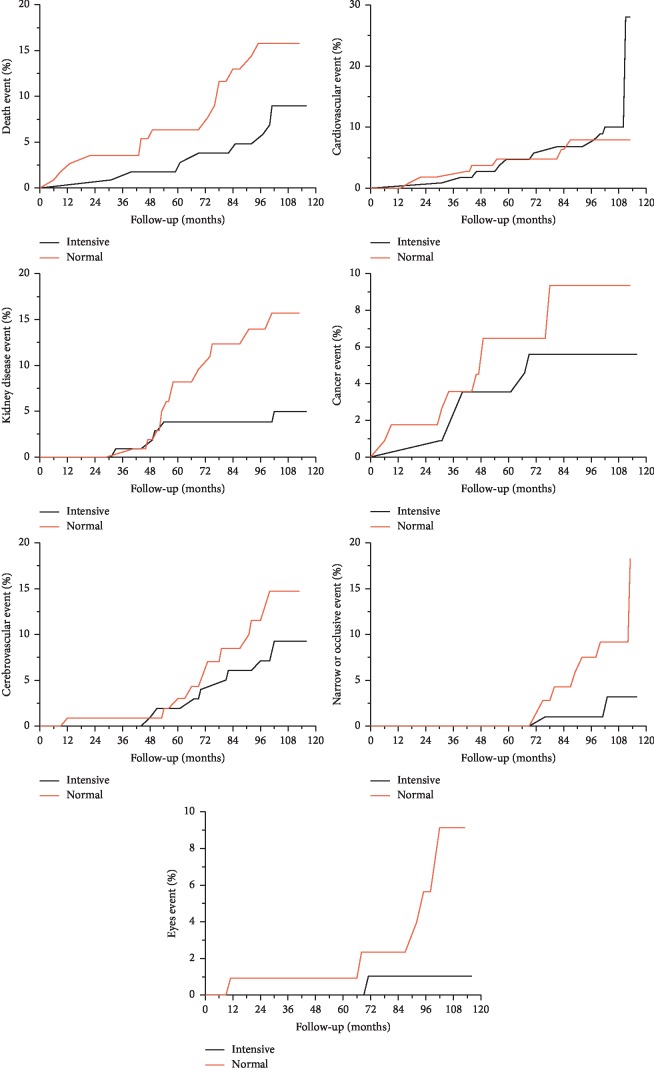
Cumulative incidences of all-cause end-point events during the follow-up between the two groups.